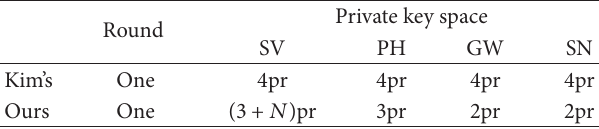
Table 5: Basic performance comparison with Kim’s scheme